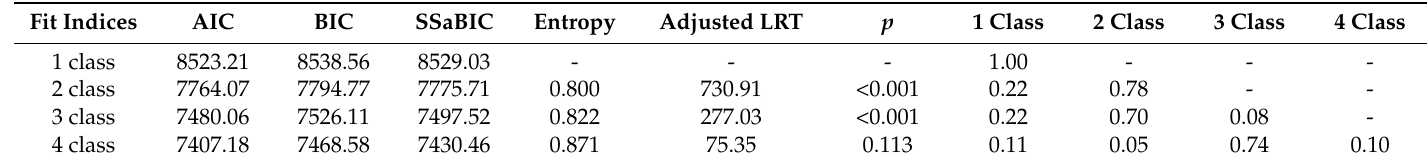
Table 2. Fit indices for one- to five-class latent class growth analysis models for guideline adherence ( n =